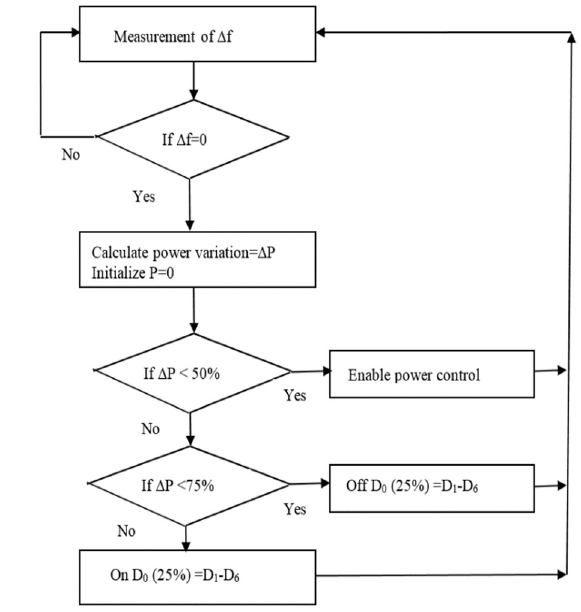
Fig. 6: Flow Chart Diagram of Designed Hybrid Scheme used for SHP